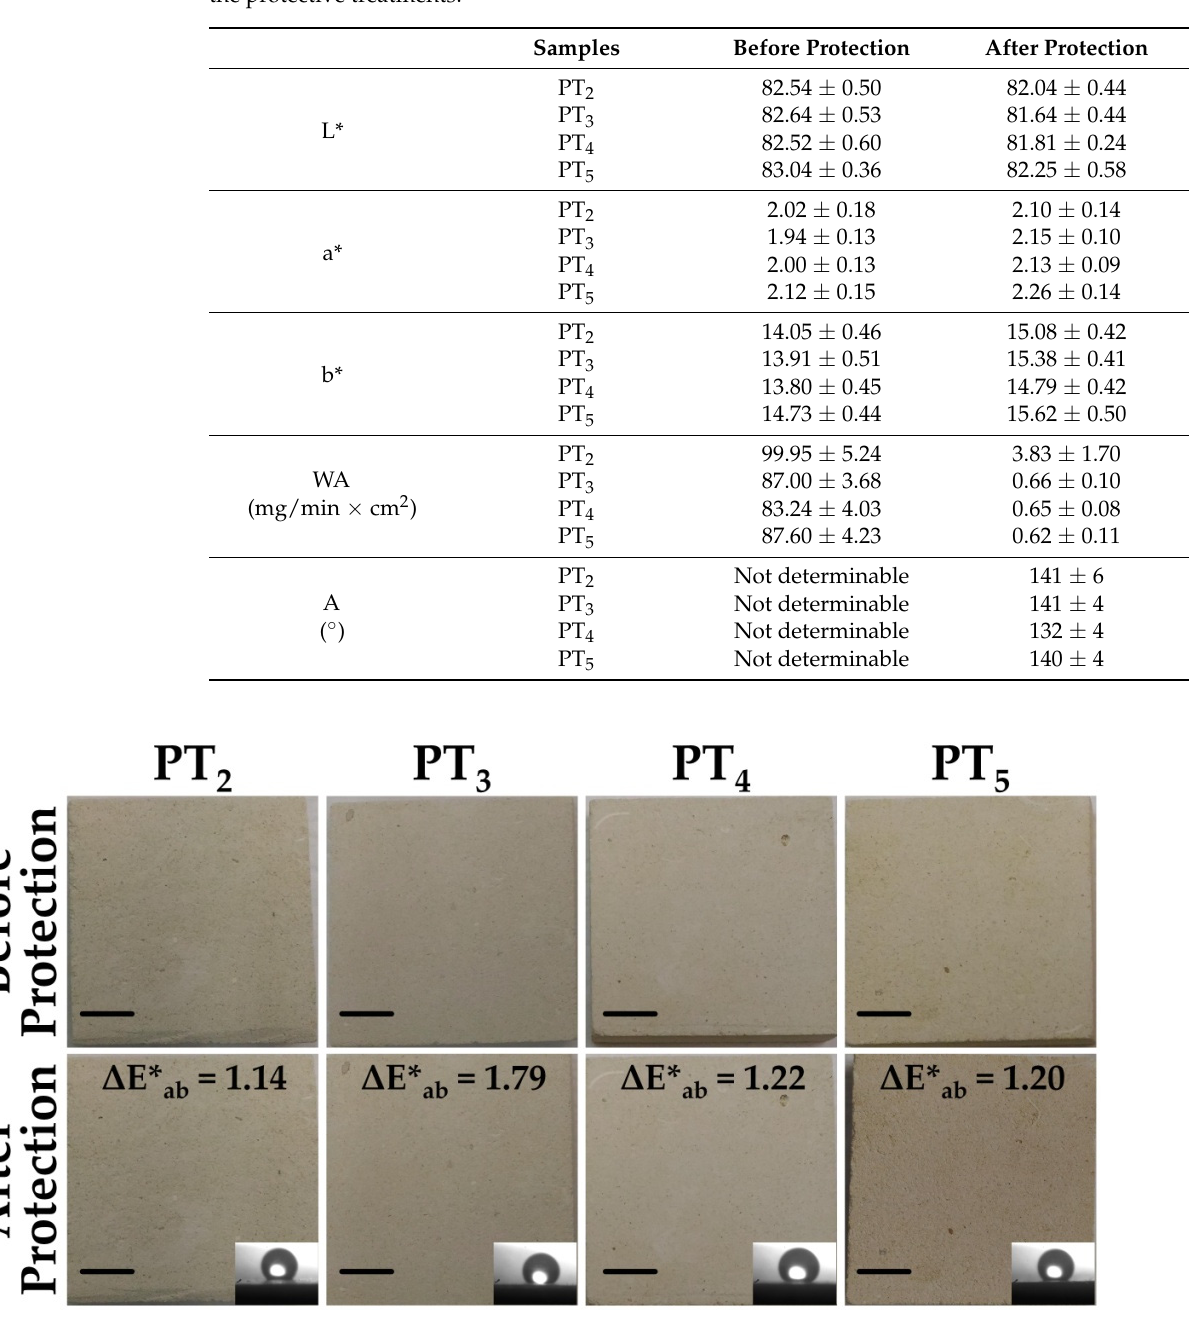
Table 3. Color parameters (L*, a*, b*), color change ( ∆ E* ab ), water absorption by “contact sponge”